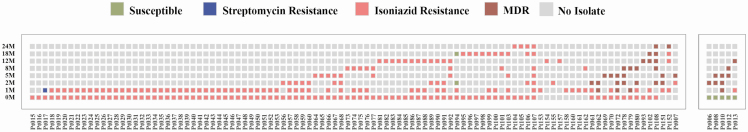
Emergence of multidrug-resistant tuberculosis (MDR-TB) during treatment in patients. Mapping of phenotypic drug susceptibility testing of longitudinal Mycobacterium tuberculosis isolates at different months (0M, 1M, 2M, 5M, 8M, 12M, 18M, and 24M) during treatment or recurrence posttreatment from 101 patients initially with isoniazid-resistant TB and 5 patients with susceptible TB. MDR-TB emergence is grouped at the bottom, confirmed based on phenotypic and genotypic drug susceptibility testing (DST). Color code indicates antibiotic susceptibility and no isolate (time points lacking positive M. tuberculosis cultures from the patients). Ninety-nine patients initially with isoniazid-resistant TB had DST results for >1 isolate, whereas 2 patients had DST for only initial 0M isolate, as later isolates failed to revive during subculture. Abbreviations: M, month; MDR, multidrug-resistant; Pt, patient.